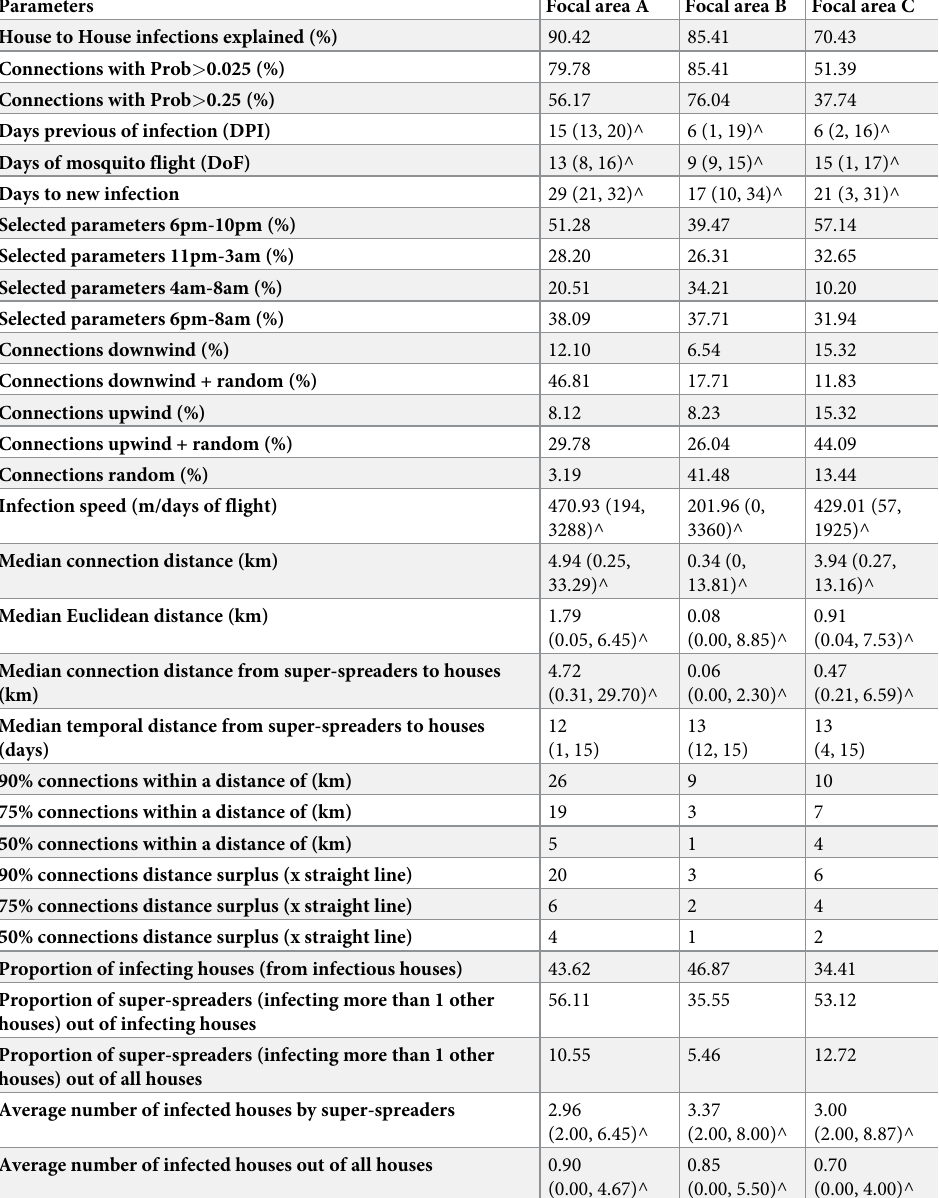
Table 2. MALSWOTS estimated optimal parameters and transmission summaries obtained from the top 5% of the models ranked by largest correlation. ^ confidence intervals. All parameters are calculated over the whole study